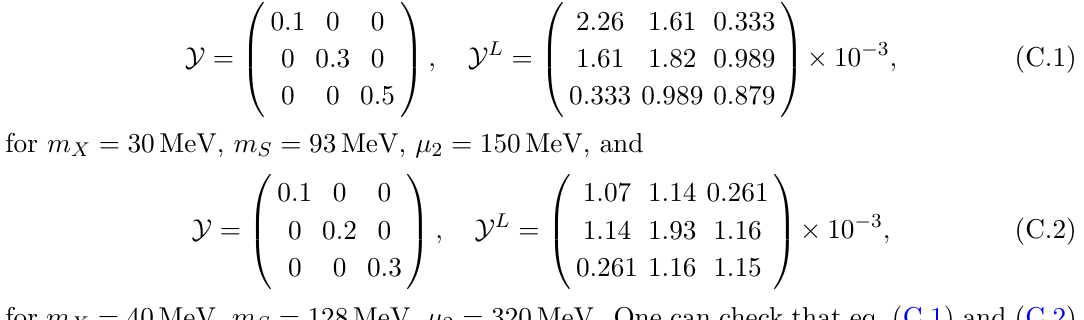
= 93 MeV, (cid:22) S